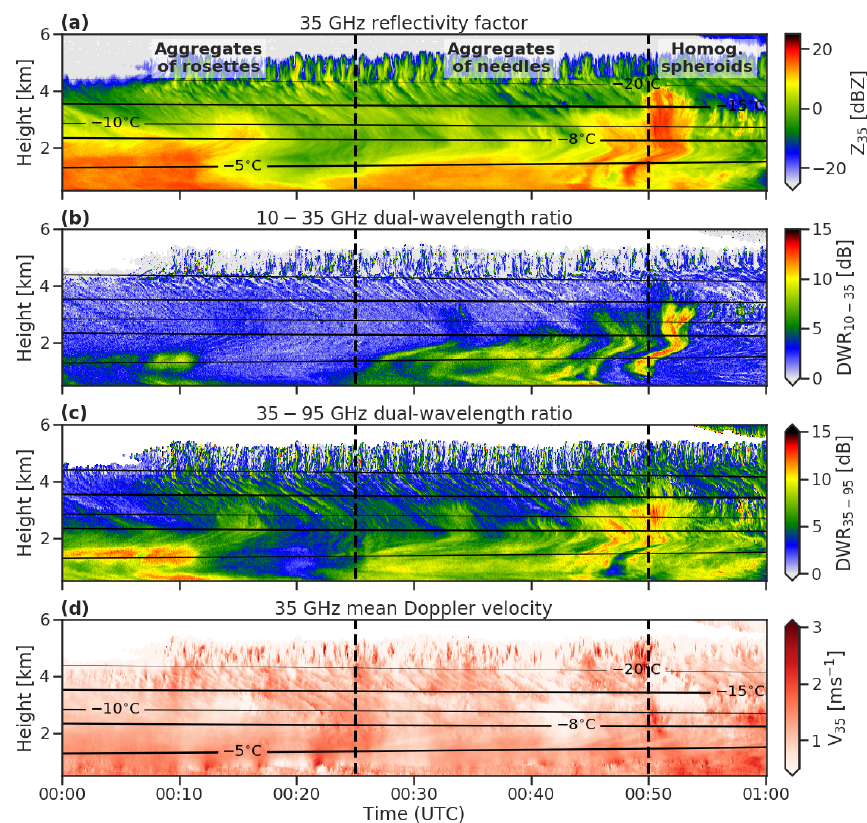
Figure 11. Triple-frequency Doppler radar measurements from the 21 February 2014 case study at Hyytiälä, Finland: (a) 35GHz radar reflectivity, (b) 10–35GHz dual-wavelength ratio, (c) 35–95GHz dual-wavelength ratio and (d) 35GHz mean Doppler velocity. Vertical dashed lines mark the transition between the rimed and unrimed snowfall regimes; solid lines are contours of temperature from ECMWF